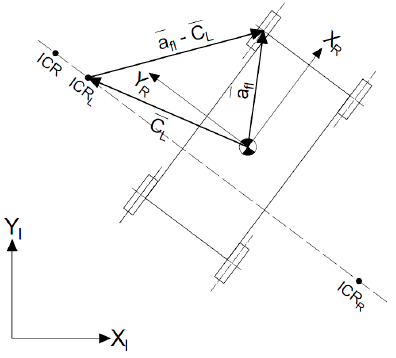
Figure 4. The replacement model for symmetrical skid-steer robot.